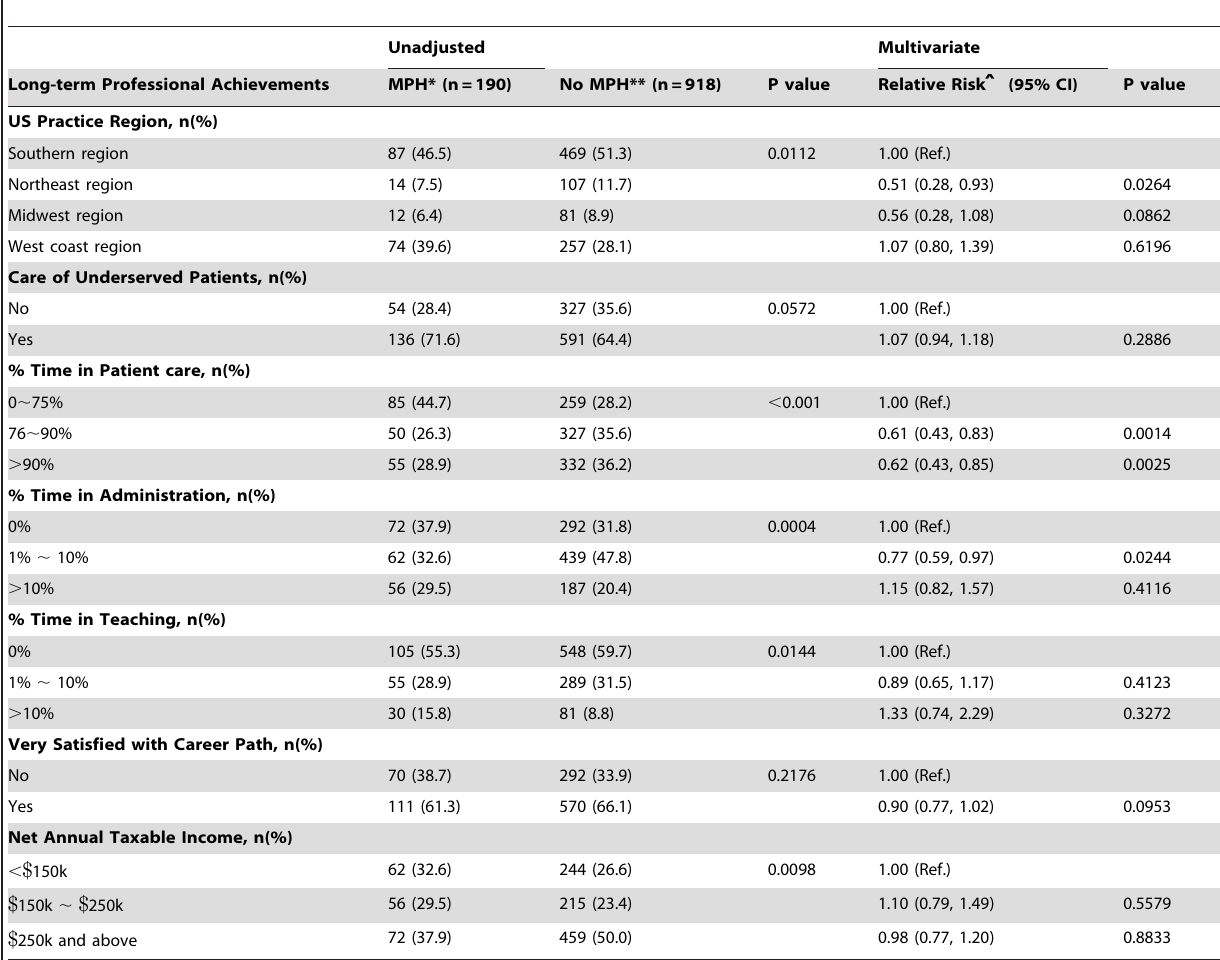
Table 4. Analyses of Long-term Practice Region, % Time in Professional Activities, and Professional Satisfaction associated with MPH Education Completion among Medical School